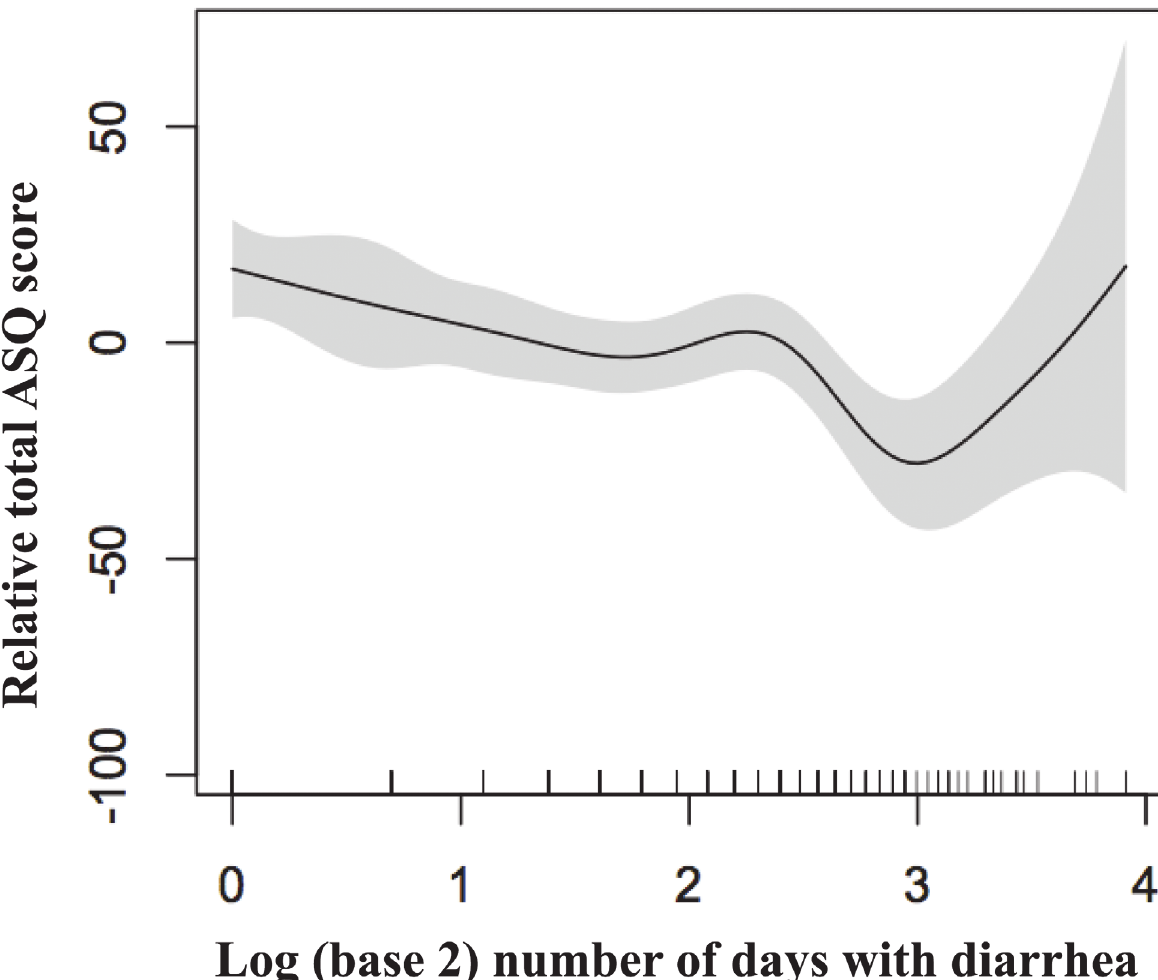
Fig 2. Associations between log (base2) days of diarrhea and changes in ASQ-scores. The graphs were constructed using generalized additive models in R, the solid line depicts the association of the total ASQ-score and log (base2) days of diarrhea. The Y-axis is centered on the mean total ASQ-score. The shaded area spans the 95% confidence interval of this